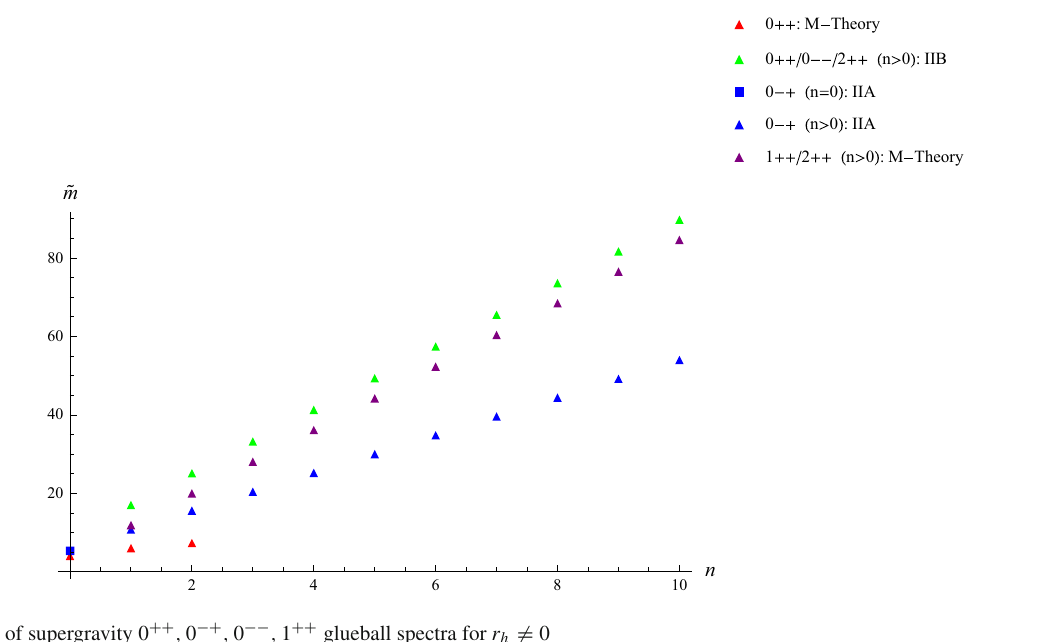
Fig. 2 Plots of supergravity 0 ++ , 0 −+ , 0 −− , 1 ++ glueball spectra for r h (cid:10)= 0 Table 2 Comparison of [62]’s N → ∞ lattice results for 0 ++ glueball with our supergravity results obtained using WKB quantization condition and redefinitions of [32] for M-theory scalar metric fluctuations State N → ∞ entry in Table 34 of [62]inunitsofsquarerootof string tension